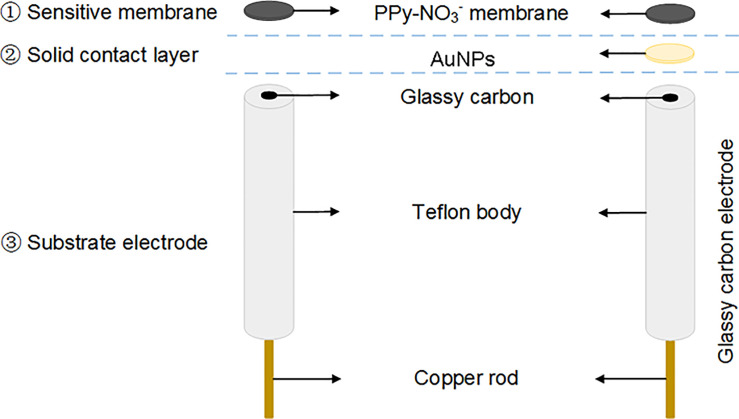
Schematic of NO3- ASS-ISE: (left) PPy/GCE and (right) PPy/AuNPs/GCE.